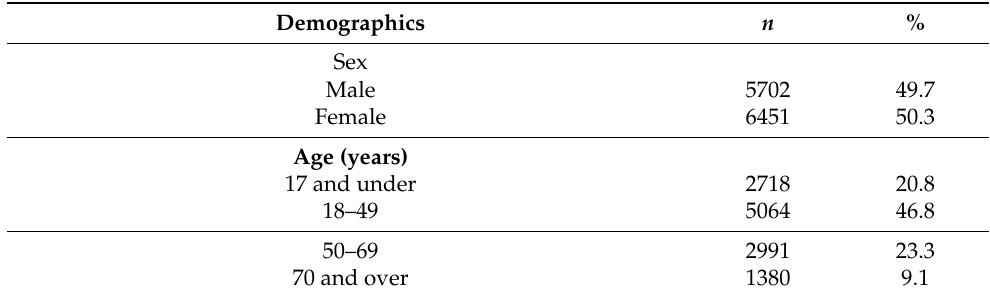
Table 1. Demographics of the population surveyed in the Australian National Nutrition and Physical Activity Survey ( n =